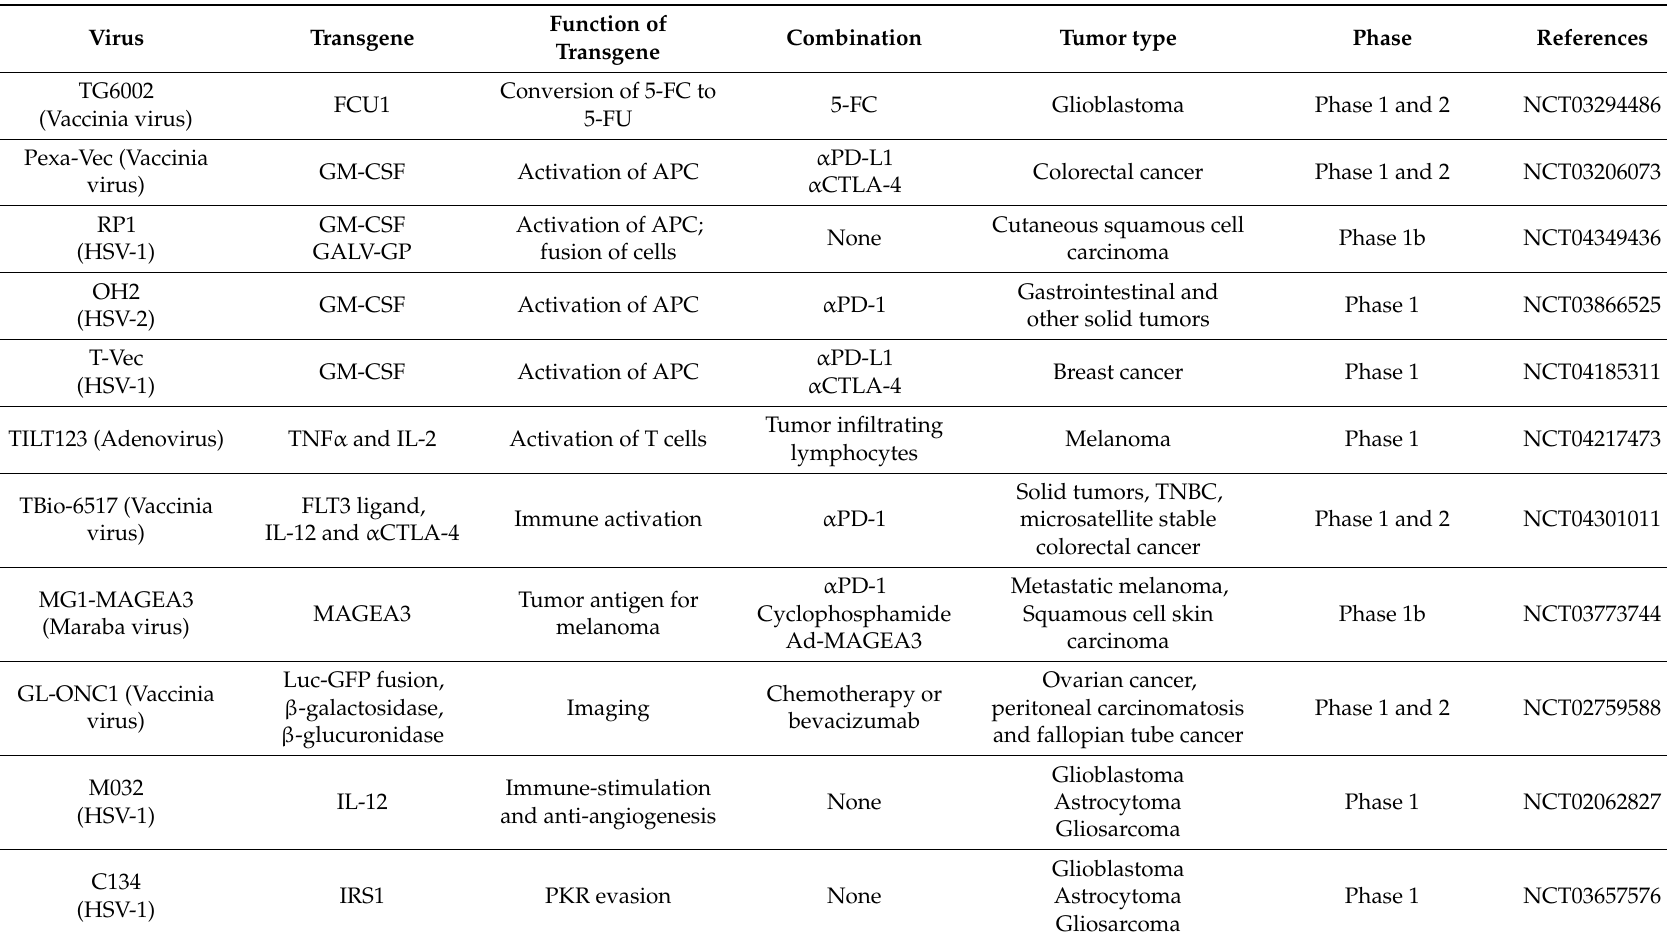
Table 2. Armed OVs currently in clinical trials (source: clinicaltrials.gov; accessed May